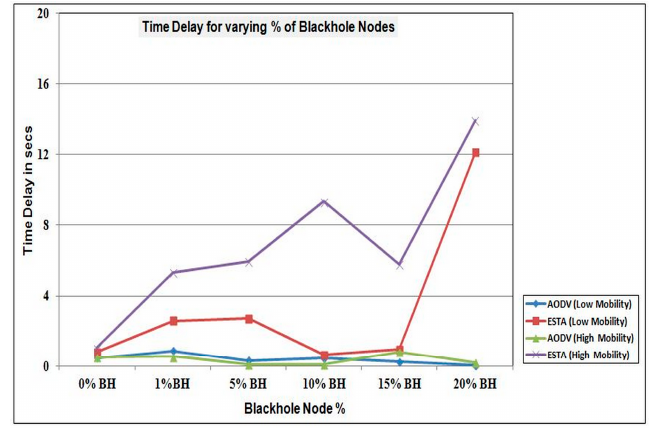
Figure 11. Time delay for varying % of blackhole nodes and